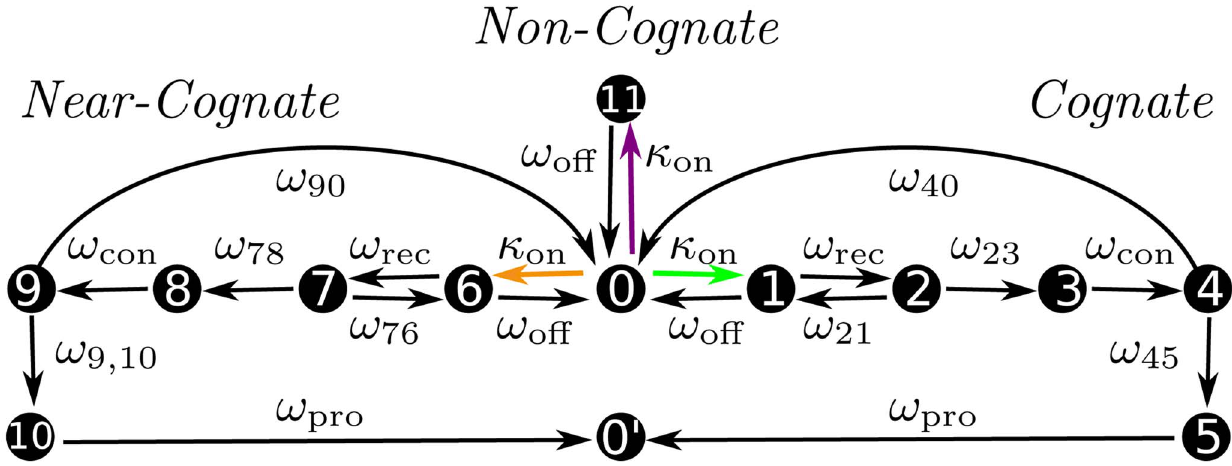
Figure 3. Codon-specific Markov process for translation elongation based on 12 ribosomal states for each codon c . The elongation cycle starts in state 0 corresponding to a ribosome without any bound ternary complex. Initial binding of a cognate, near-cognate, or non-cognate ternary complex is indicated by the green, orange, and purple arrow, compare the color code in Fig. 4; the corresponding association rates are proportional to the association rate constant k on as in Eq. 9. The black arrows represent the individual transitions along the reaction pathways. All ternary complexes dissociate initially with the same dissociation rate v off . Likewise, cognate and near-cognate ternary complexes are governed by the same recognition rate v rec , conformational rate v con , and processing rate v pro . The kinetic distinction between the cognate and near-cognate branches arises from initial selection at the states 2 and 7 as well as from proofreading at the states 4 and 9.